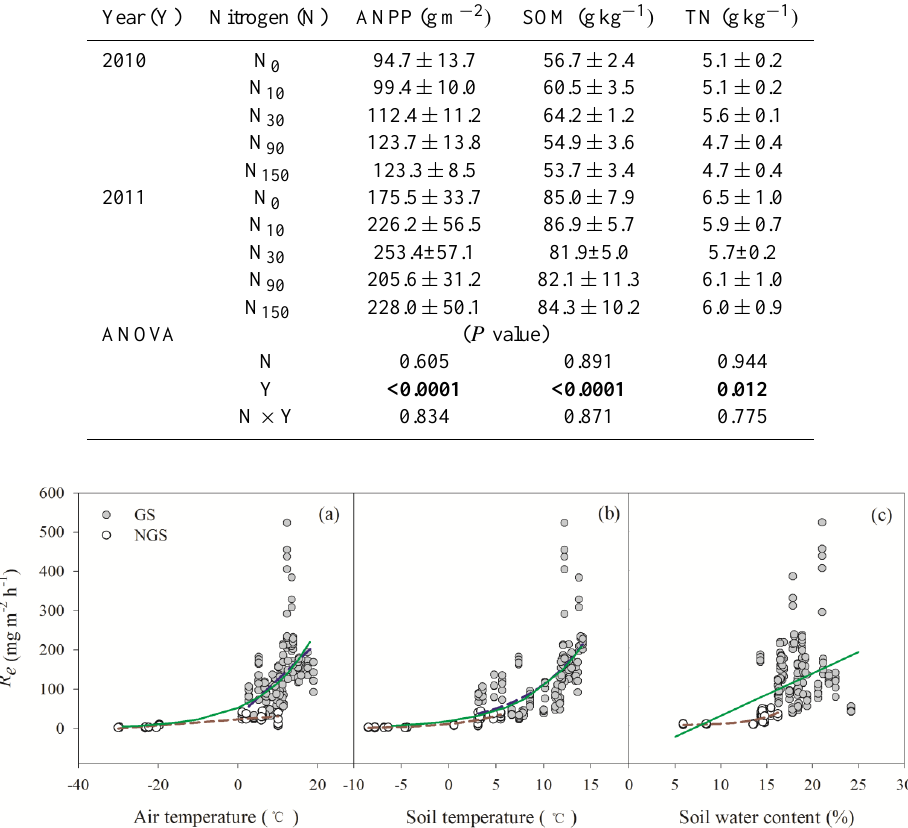
Fig. 2. Relationships between CO 2 fluxes ( R e ) and air temperature (a) , soil temperature at 10cm depth (b) and soil water content at 10cm depth (c) . Green, dark red and dark blue lines represent the best fitted relationship between R e and biotic factors over the whole year, outside the growing season (NGS) and within the growing season (GS), respectively. 874